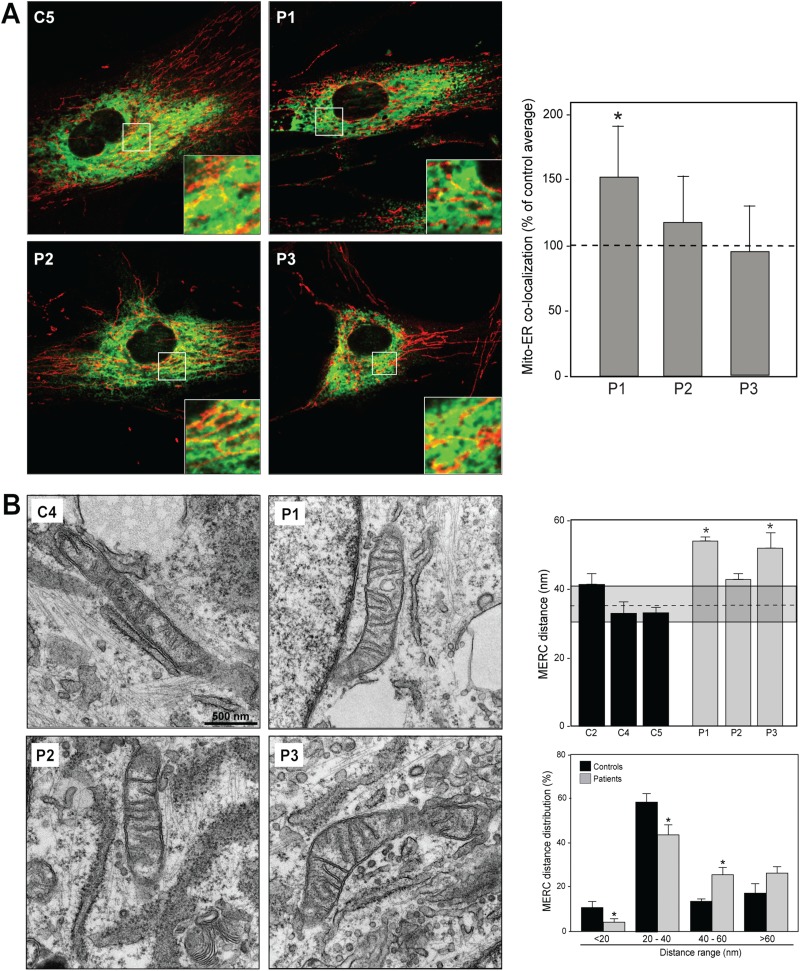
ER–mitochondrial connectivity in CMT2AMFN2 fibroblasts. (A) Representative confocal microscopy of ER (anti-PDI; green) and mitochondria (anti-TOM20; red). Quantification at right. (B) Representative EM pictures of ER and mitochondria in the indicated cells. Quantitation of mitochondria–ER contacts (MERC), a measurement of inter-organellar distance. The dotted line within the shaded box denotes the control average ± SD (top right), and histograms of the distribution of ER–mitochondrial distances in the averages of the controls and the patients (bottom right). n = 3; *P < 0.05. Other parameters of ER–mitochondrial apposition are shown in Supplementary Material, Figure S3.